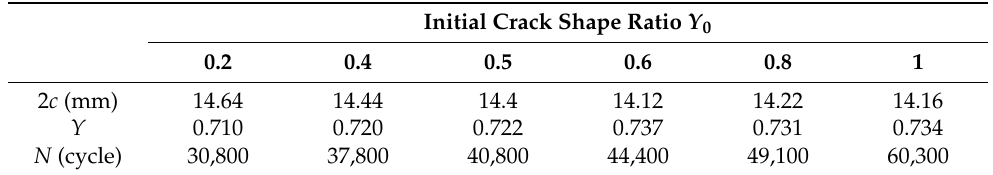
Figure 9. The a-N curve of initial crack growth with different shape ratios. Table 4. Crack growth results with different initial shape ratios.